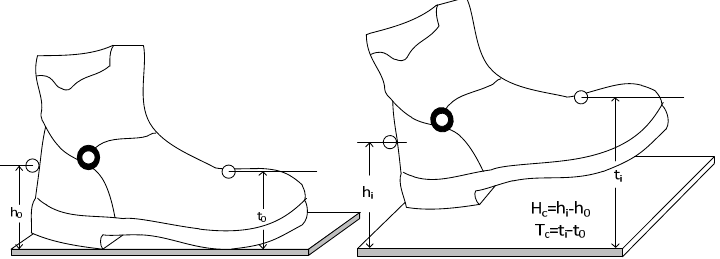
Figure 3. Toe and Heel Clearance Measurement Technique from foot